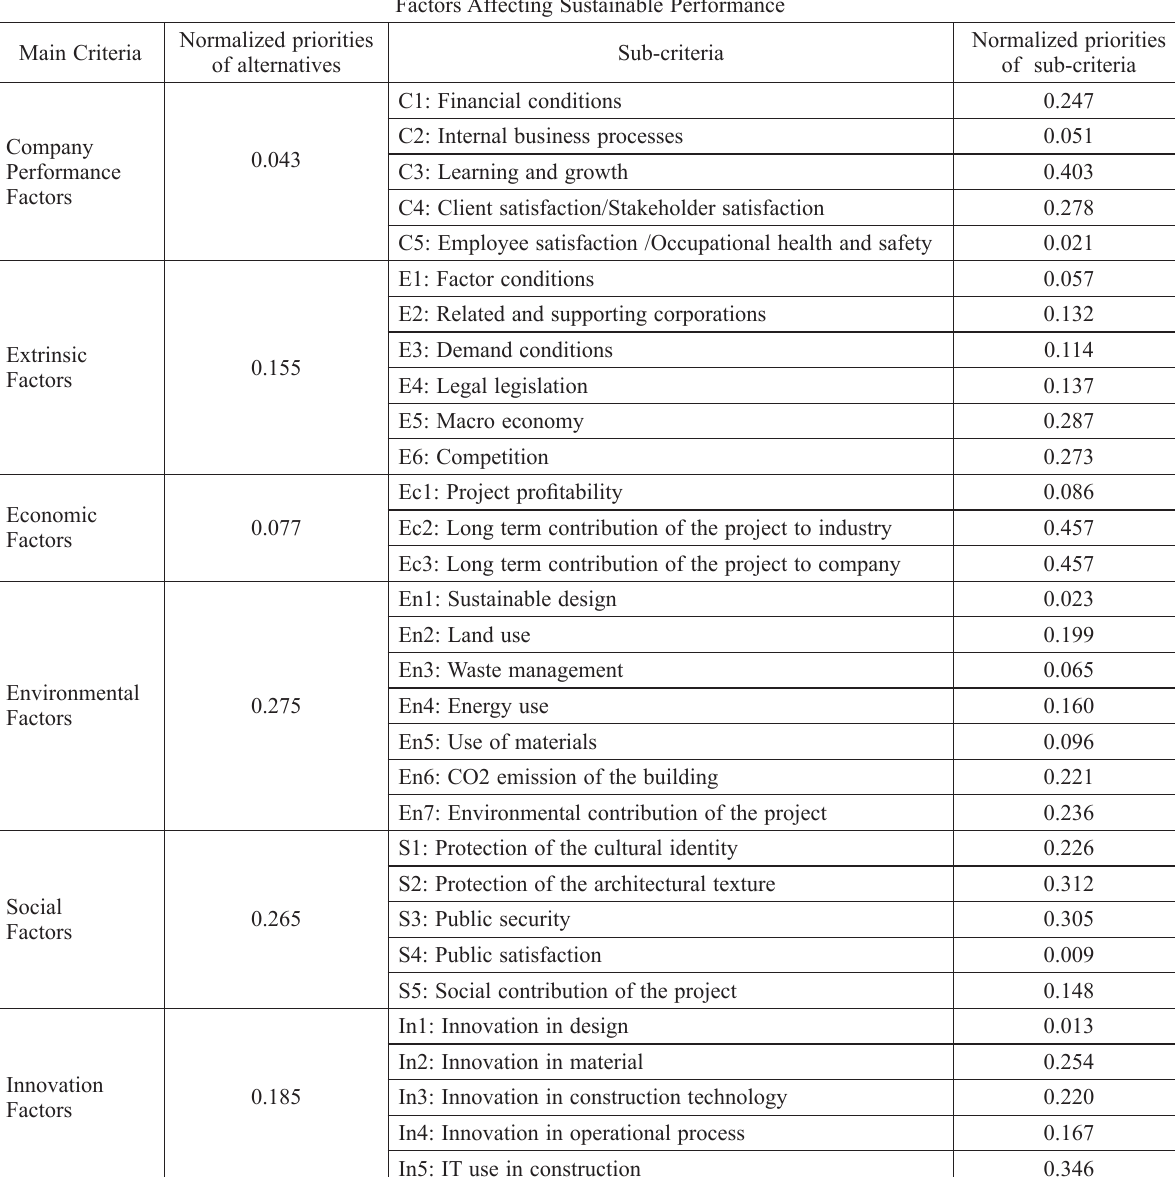
Table 8. The synthesized priorities of sustainability factors Factors Affecting Sustainable